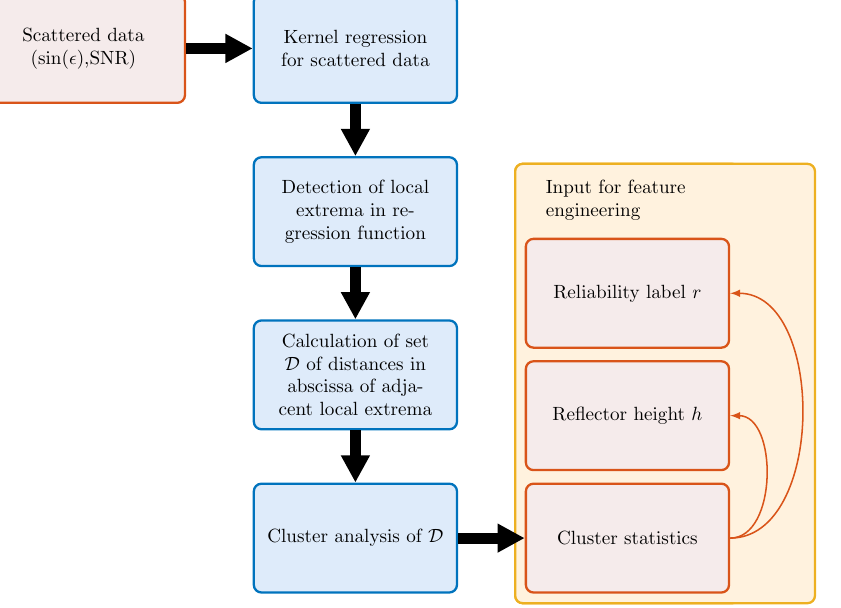
Figure 5. Flow illustrating the estimation of the reflector height with associated reliability label. The quantities used for the engineering of features for the prediction of the SWH are highlighted in the yellow